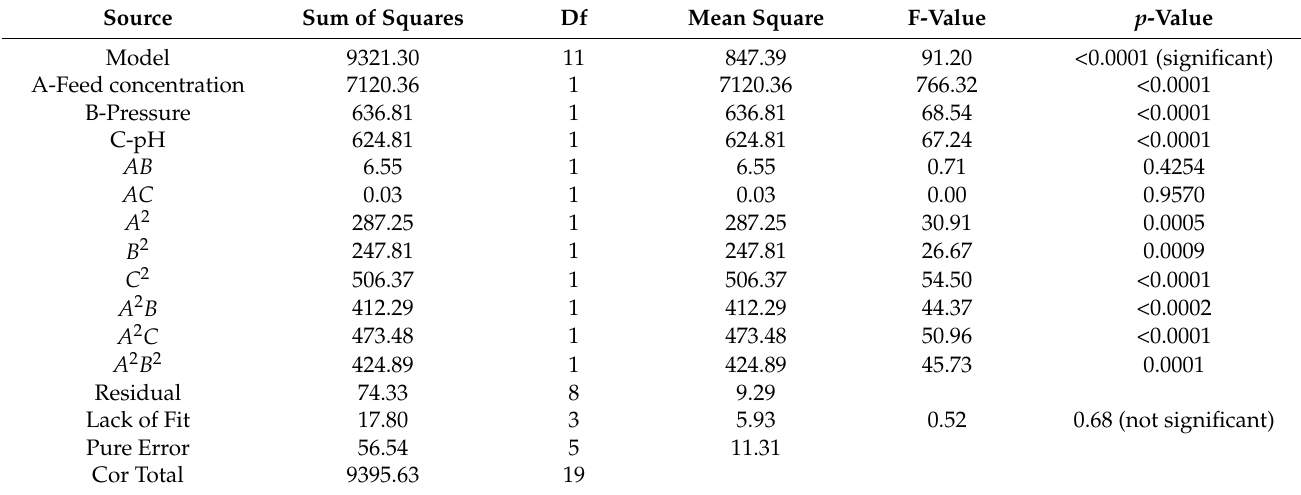
Table 3. Analysis of variance of the developed oil rejection-based modified cubic model.